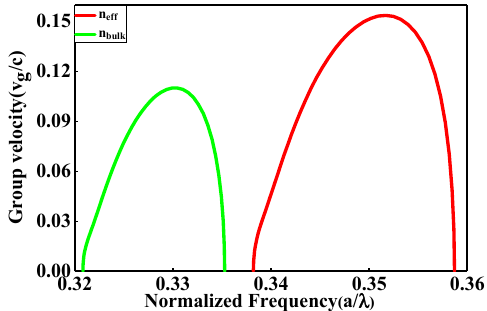
(cid:0) (cid:1) Figure 7. Group velocity (𝑣 (cid:3034) /𝑐) for TM guided mode with the normalized frequency 𝑈 = v g / c Figure 7. Group velocity for TM guided mode with the normalized frequency 𝜔𝑎/2𝜋𝑐 = 𝑎/𝜆 for 2-D calculations with 𝑛 (cid:3032)(cid:3033)(cid:3033) = 3.2 approximation and 𝑛 (cid:3029)(cid:3048)(cid:3039)(cid:3038) = 3.48 of the opti- U = ω a /2 π c = a / λ for 2-D calculations with n ef f = 3.2 approximation and n bulk = 3.48 of the mized mode at 𝑙 = 1.50𝑎 . optimized mode at l = 1.50 a